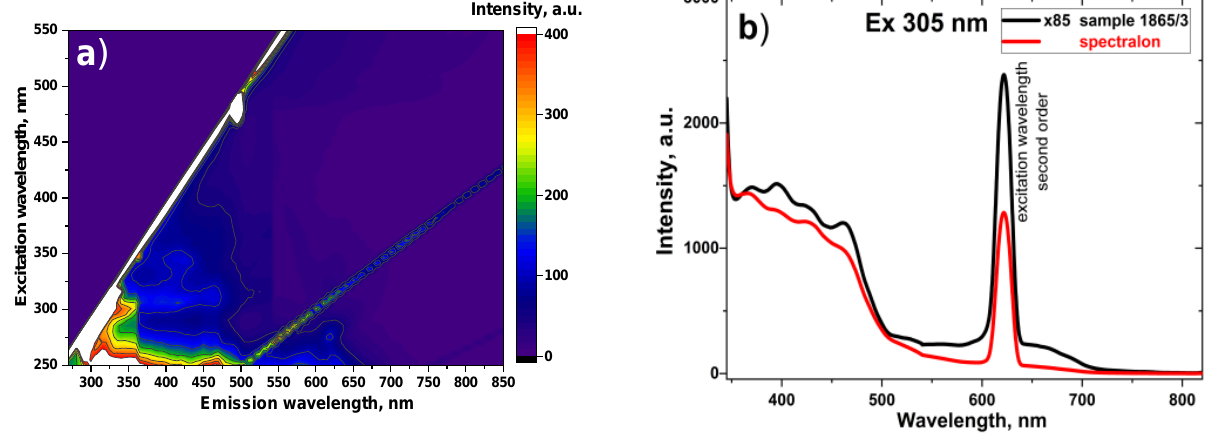
Figure 1. ( a )—Fluorescence spectra map for isolated plant fossil sample No 4734/67; ( b )—fossil sample No 4734/67 and Spectralon ® fluorescence spectra comparison with the 305 nm excitation.